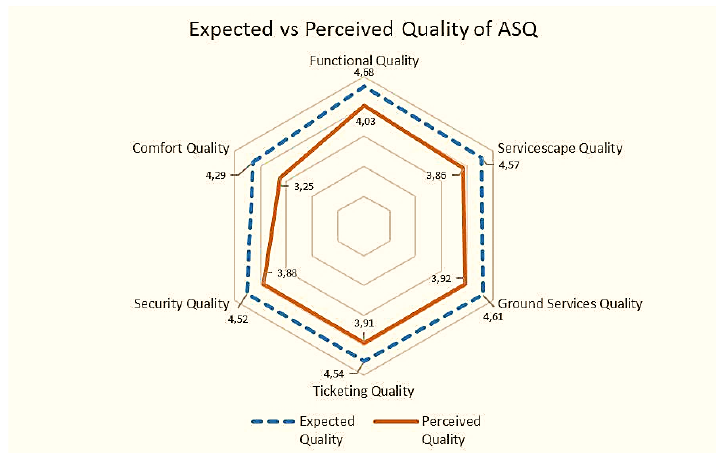
Figure 1. Expected vs. perceived quality of airport service